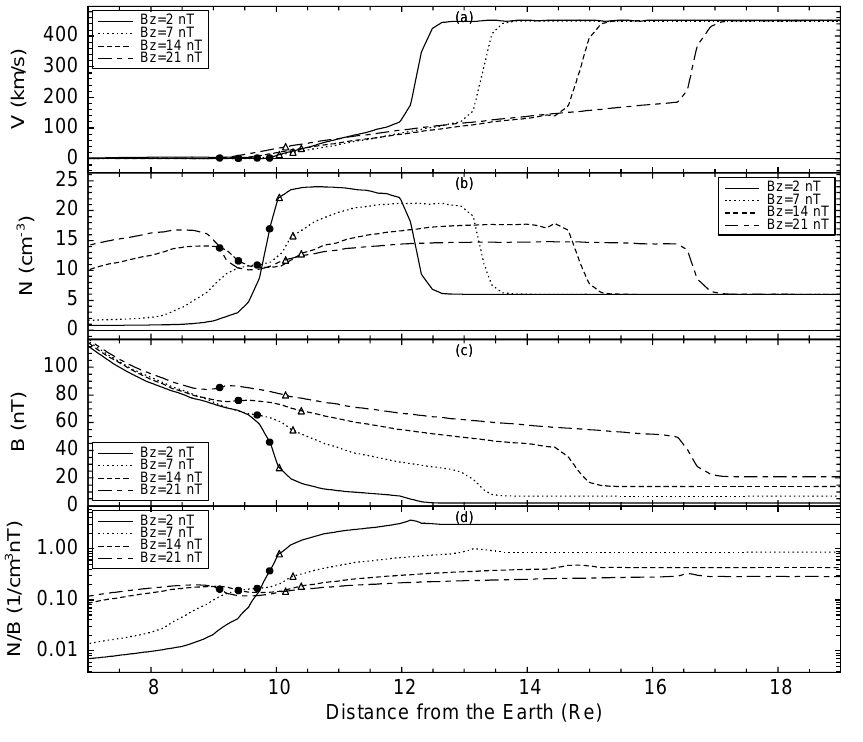
GSE z=0 plane moves more perpendicular to magnetic